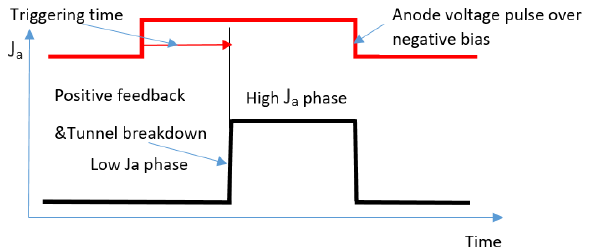
Figure 1. Operating scheme of dynamical semiconductor sensor. Ja is the anode current. Reprinted with permission from ref. [36]. Copyright 2019 IEEE.